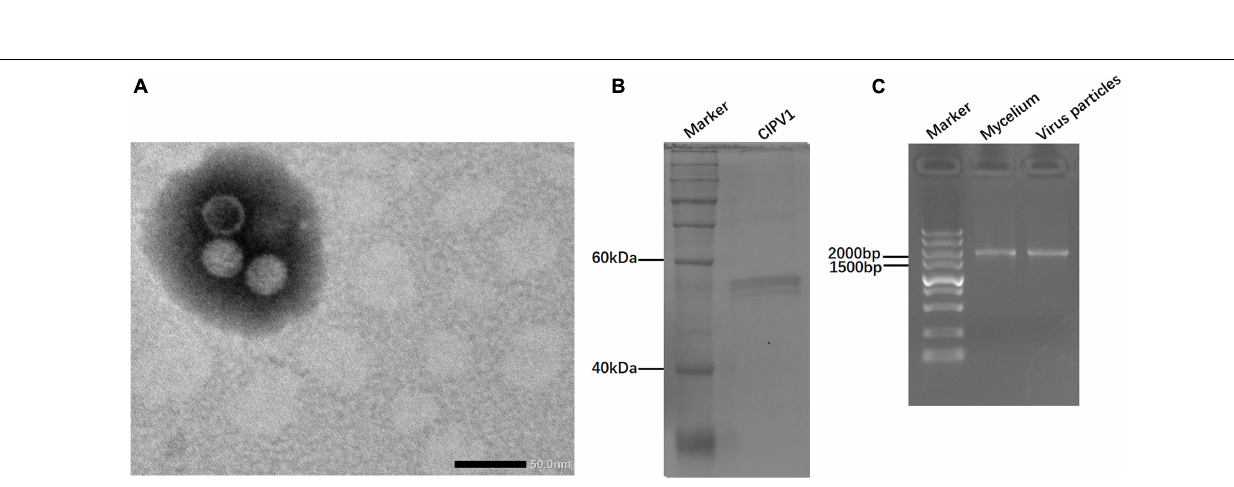
Frontiers in Microbiology |